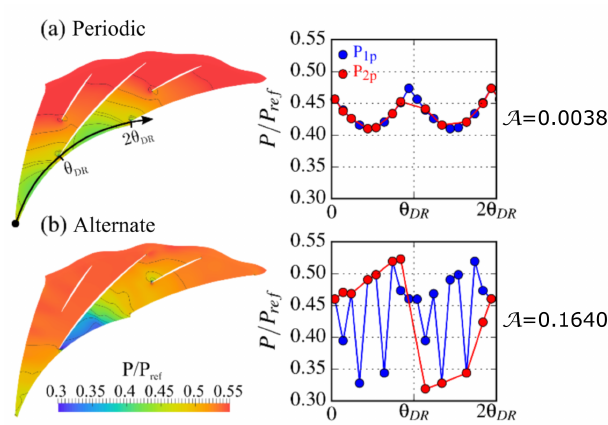
Figure 1. Illustration of the alternate rate on two numerical static pressure